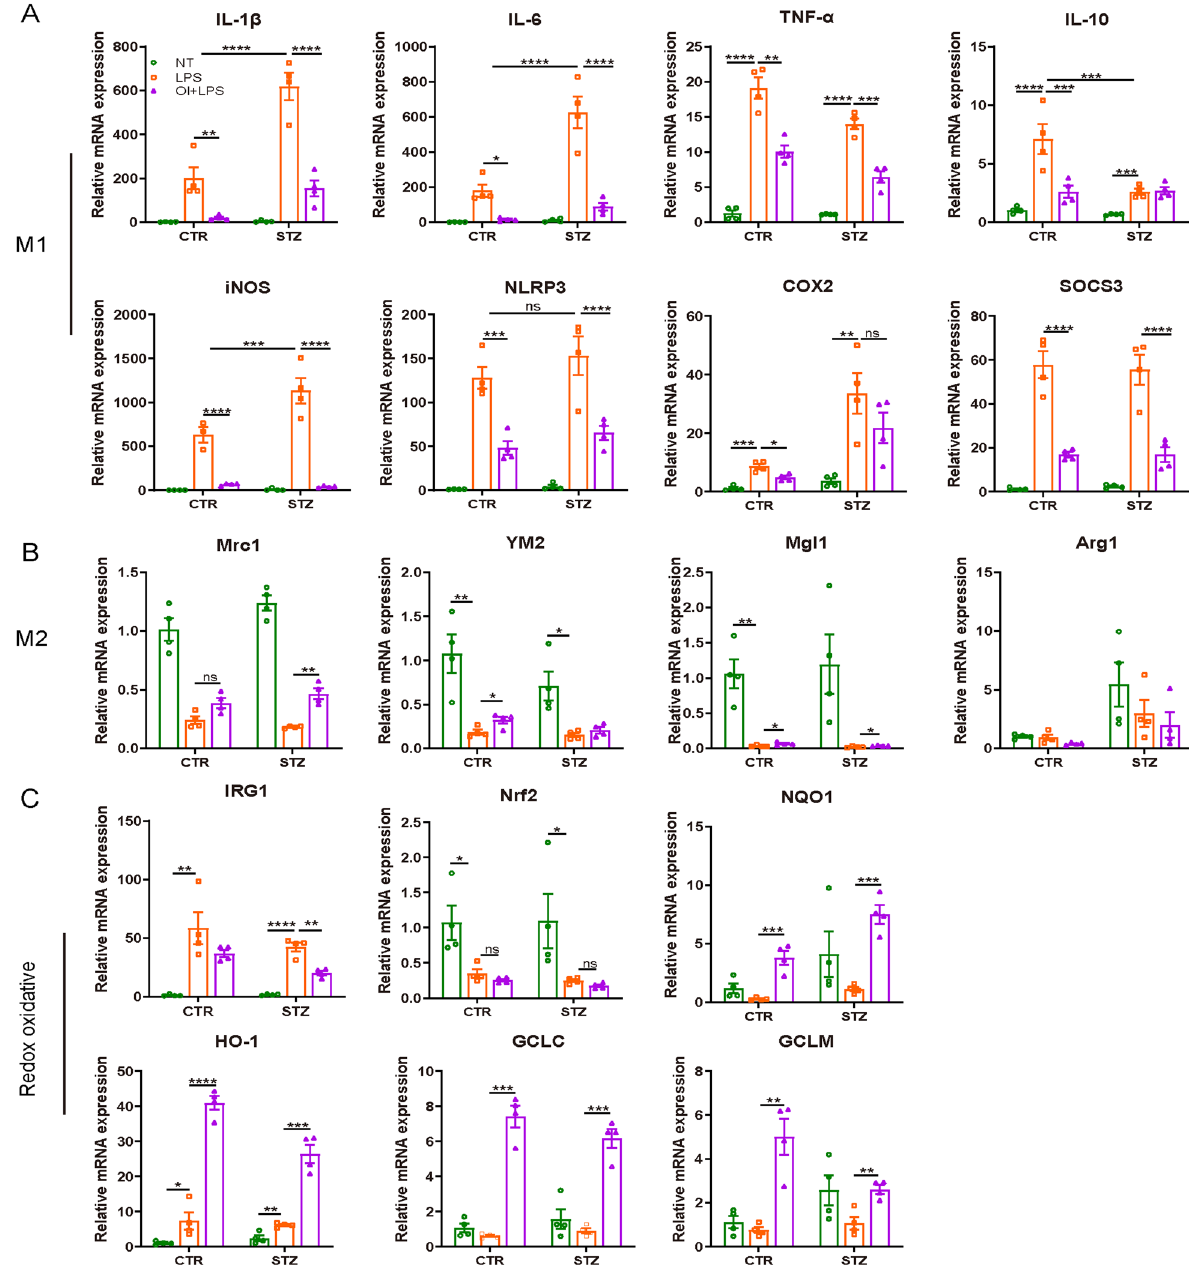
Fig. 6 The effect of OI on oxidative stress gene expression and macrophage polarization. The peritoneal macrophages from healthy and diabetic mice were collected and were pretreated with 125 μM OI or NT for 2 h, followed by LPS, OI was extracted and the expression of the M1-, M2-, and oxidative-related genes were measured by real-time PCR ( n control was β-actin. A M1-related genes expression. B M2-related genes expression. C Oxidative-related genes expression. The results are shown as the mean SD. * p < 0.05, ** p < 0.01, *** p < 0.001, and **** p < ±